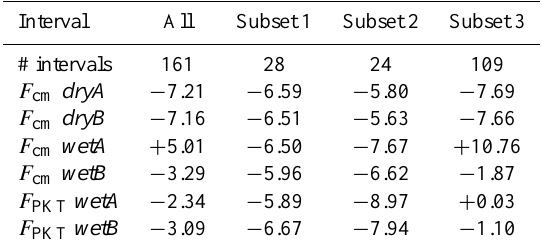
Fig. 2. Overview of conditions encountered during the SOAP exper- iment. Shaded areas mark low latent heat fluxes (Hl ≤ 7Wm − 2 ). The wind speed measurement was taken on the ship’s main deck and is corrected for air-flow distortion (Popinet et al., 2004) and normalised to standard conditions (10m height and neutral stabil- ity). This wind speed was used to calculated the bulk fluxes with the TOGA COARE 3.0 algorithm. All direct EC fluxes are measured at the bow mast using the Csat3 sonic anemometer and the IRGA in the science container on the foredeck.